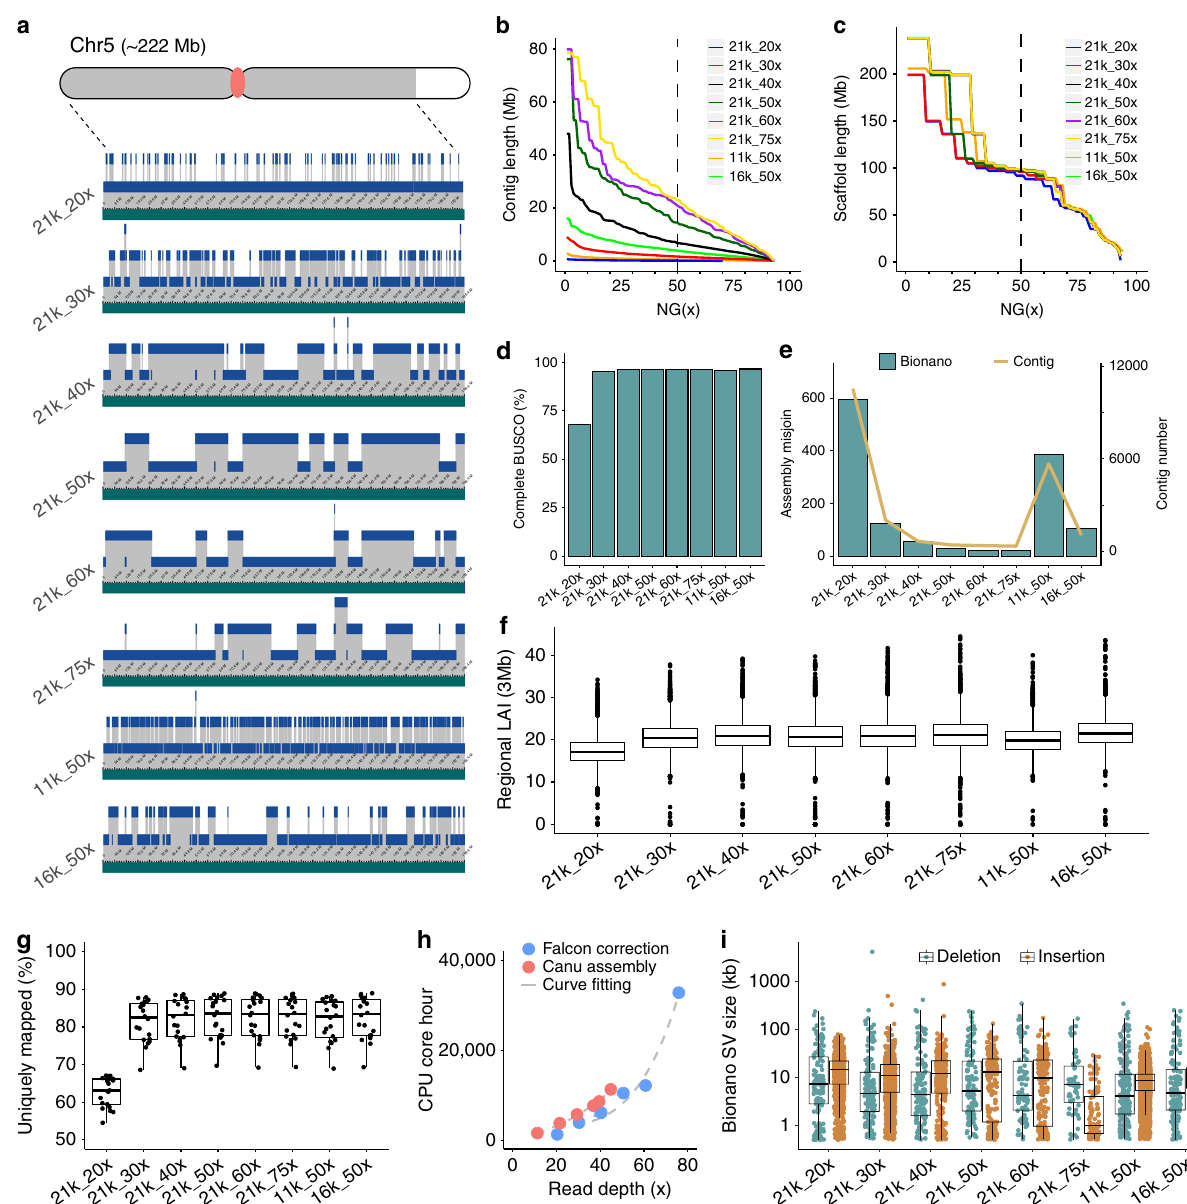
Fig. 1 Assembly of NC358 using various read lengths and coverage. a Hybrid scaffolding using the Bionano optical map. A 199Mb scaffold from chromosome 5 is shown. Gray areas on the chromosome cartoon represent the 199Mb scaffold; the white area is the remaining 23Mb scaffold in chromosome 5; the red dot is the centromere. Green tracts represent scaffolded sequences and blue tracts show the contigs that comprise this scaffold with contigs jittered across three levels. b Contig NG(x). c Scaffold NG(x). d Benchmarking Universal Single-Copy Orthologs (BUSCO) of Pilon-polished assemblies. e The number of assembly misjoins revealed by DLE-1 con fl icts and the number of contigs of each assembly. f Regional LTR Assembly Index (LAI) values estimated based on 3Mb windows with 300kb steps. The box shows the median, upper, and lower quartiles. Whiskers indicate values ≤ 1.5× interquartile range. Outliers are plotted as dots. g Unique mapping rate of RNA-seq libraries. A total of ten tissues with two biological replicates were sequenced. Each dot represents an RNA- seq library. The box shows the median, upper, and lower quartiles. Whiskers indicate values ≤ 1.5× interquartile range. h Central processing unit (CPU) core hours required for Falcon correction and Canu assembly. i Bionano optical map inconsistency. Deletions and insertions are cases where sequences are shorter or longer than the size estimated by the optical map, respectively. Structural variations (SVs) are plotted as dots. The box shows the median, upper and lower quartiles. Whiskers indicate values ≤ 1.5× interquartile range. Source data underlying Fig. 1b, c, f, g are provided as a Source Data fi